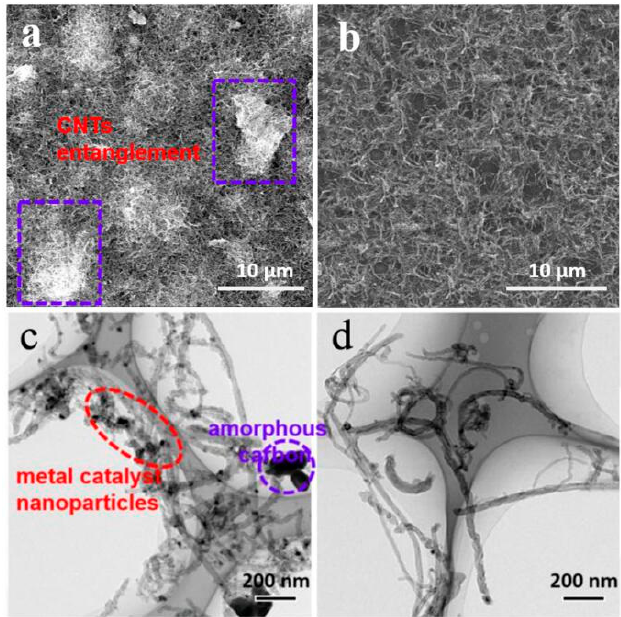
Figure 2. SEM images of crude CNTs ( a ) and purified CNTs ( b ), and TEM images of crude CNTs ( c ) and purified CNTs ( d ).